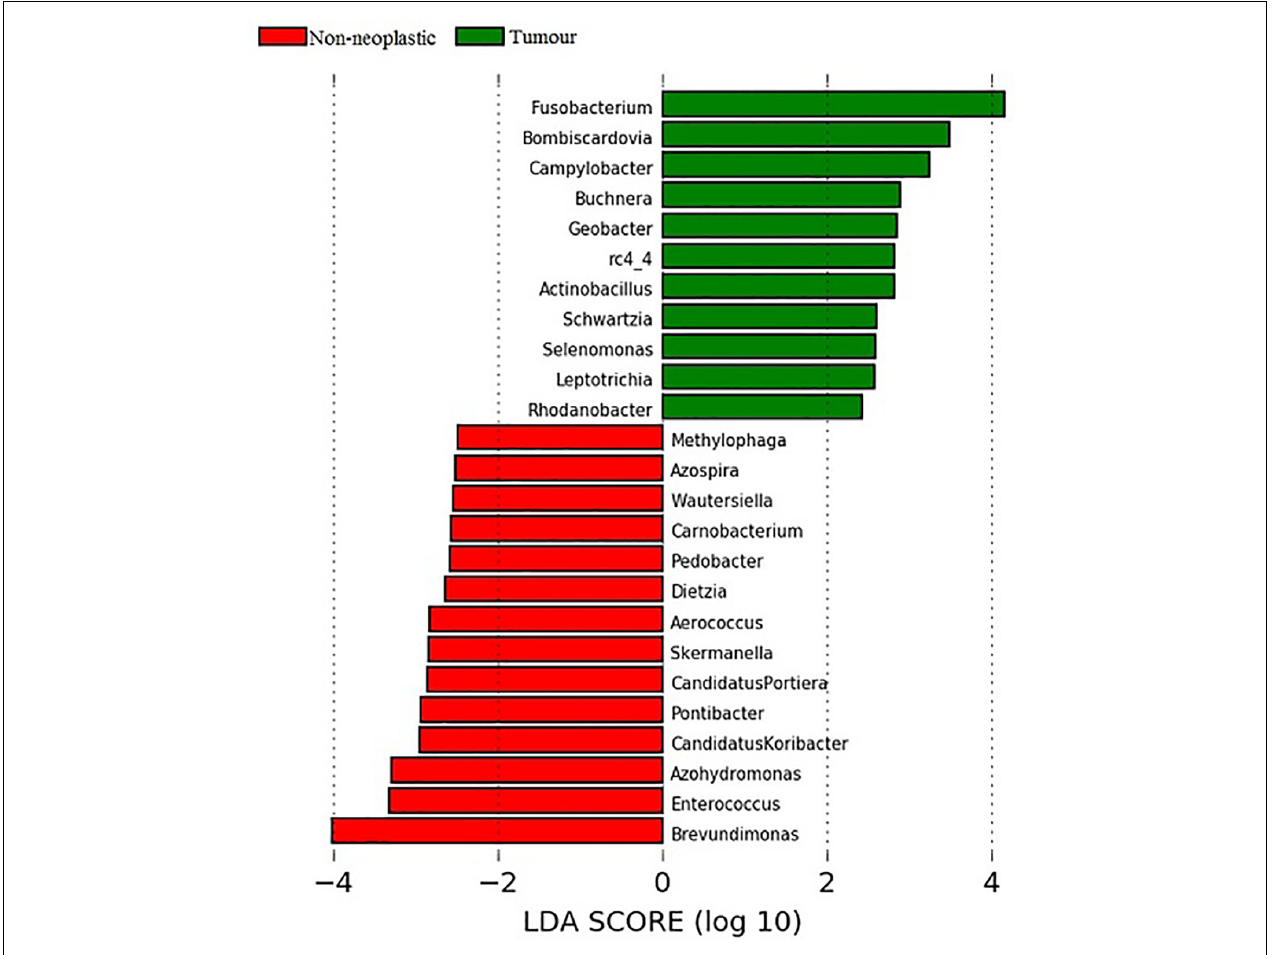
FIGURE 6 | Analysis of key genera that contribute to the structure of mucosal microbiota in the non-neoplastic mucosae and